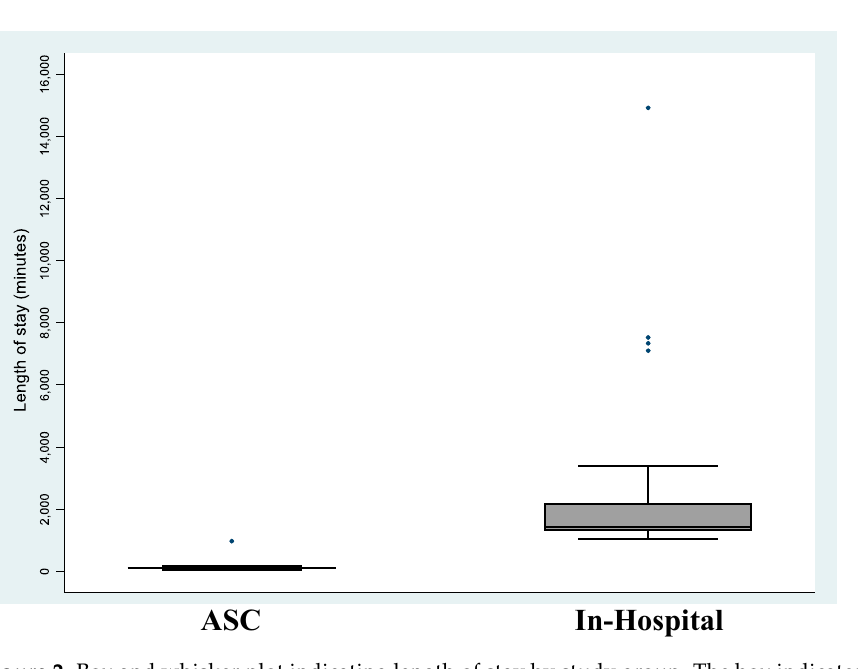
Figure 2. Box and whisker plot indicating length of stay by study group. The box indicates the upper and lower quartiles, and the central line is the median. The points at the end of the “whiskers” are the 2.5% and 97.5% values.